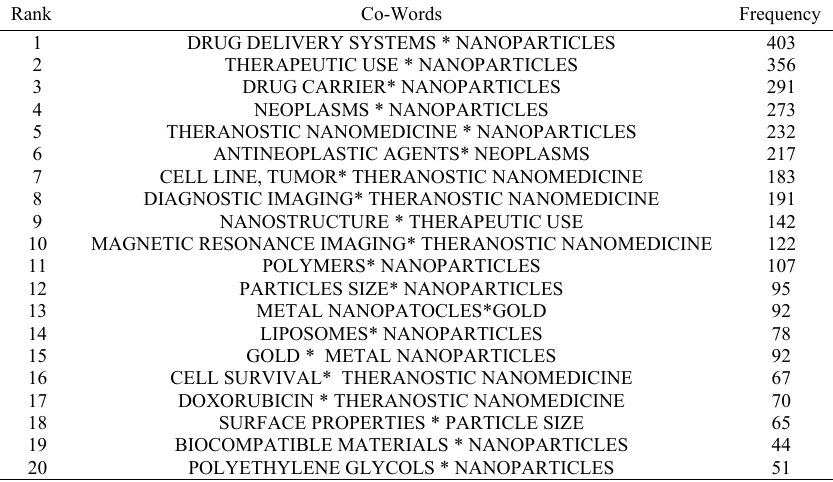
Fig. 2. Keyword network map for nanomedicine research papers over the period 2009-2018 Table 4. The top 20 pairs of frequently-used keywords